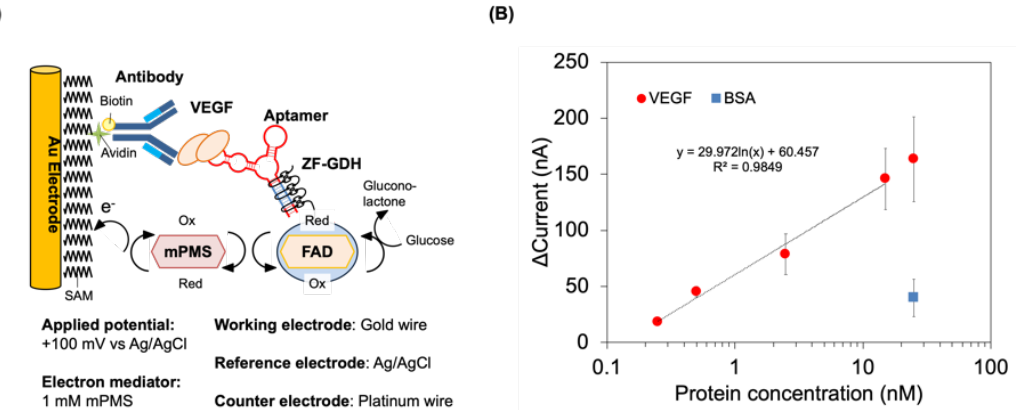
Figure 2. Electrochemical detection of VEGF. ( A ) Schematic diagram of the electrochemical detection of VEGF. ( B ) Electrochemical detection of VEGF by using ZF-GDH-labelled aptamer. The GDH activity was measured by chronoamperometry in the presence of 1 mM mPMS and 100 mM glucose with an applied potential of 0.1 V (vs. Ag/AgCl). The delta current is defined as the subtraction of background current before addition of glucose from the plateau signals after the addition of glucose. Error bars indicate standard deviations ( n =